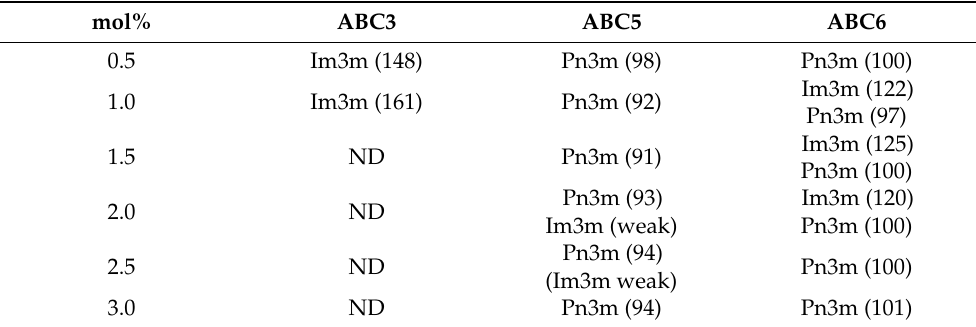
Figure 4. SAXS diffraction patterns of MO nanoparticles stabilized by PTBA-containing polymers, viz. ABC3 ( a ), ABC5 ( b ) and ABC6 ( c ) at various concentrations after incubation with 50 mM H 2 O 2 solution. All measurements were performed at 25 ◦ C. Table 2. Mesophase identification and calculated lattice parameters (Å) of the MO nanoparticles stabilized by the synthetic ABCs in the presence of 50 mM H 2 O 2 .